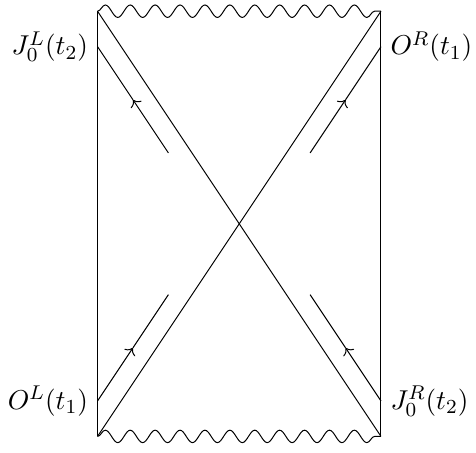
Figure 3 . in and out sates in a symmetric regularization